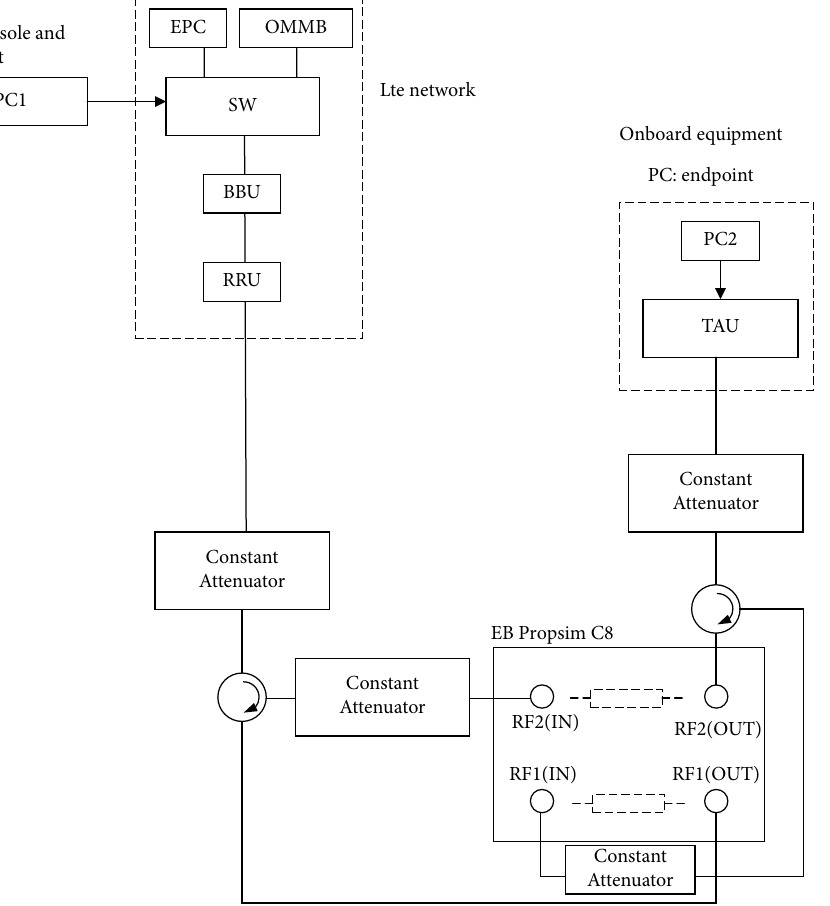
Figure 5: Communication test link between train and ground